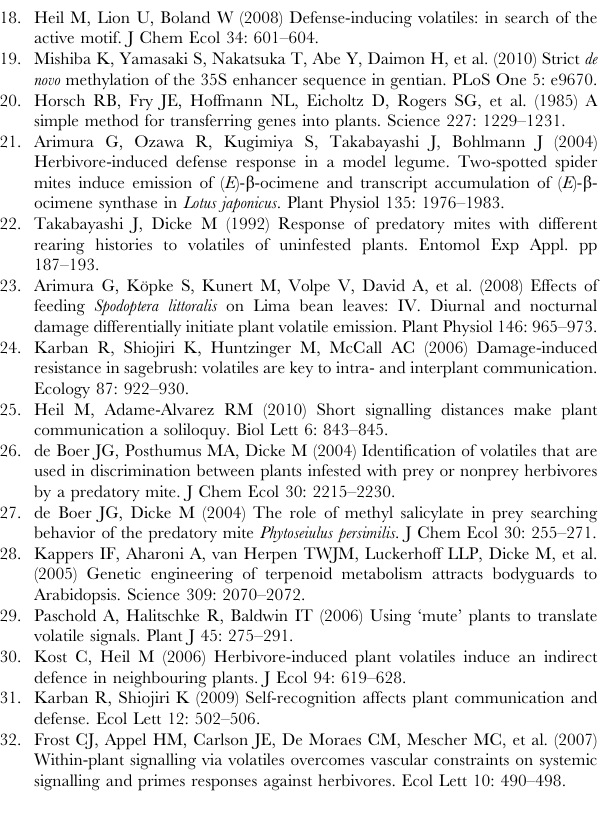
Figure S1 Schematic drawing of experimental set-up for inter-plant communication assay. Figure S2 VOC-primed defense responses in receiver lima bean plants to damage by T. urticae in greenhouse conditions. Uninfested plants were placed 30 cm ( A ) or 60 cm ( B ) apart from NtOS2 (VOCos) or WT (VOCwt) in a greenhouse for 7 days. The number of eggs laid by a T. urticae female on a receiver leaf section was determined for up to 3 days. Data